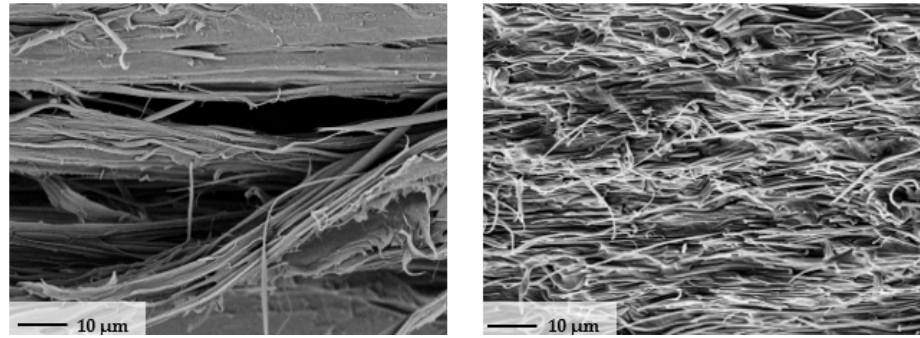
Figure 12. SEM micrographs of fractured PP/22 wt% PET.